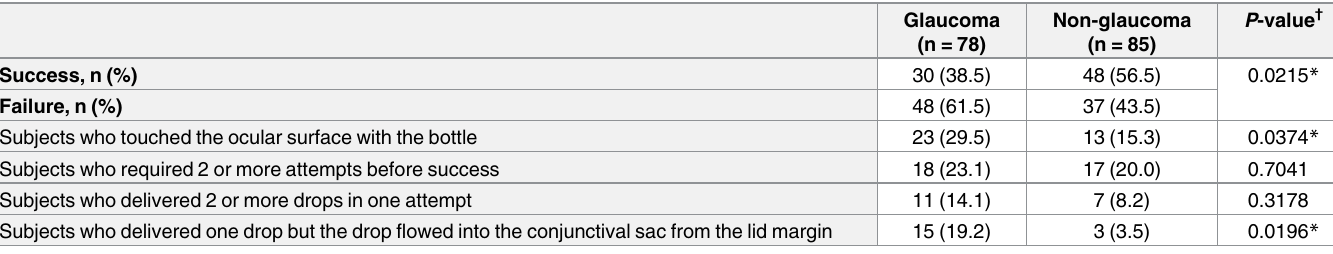
Table 2. Success and failure rates of eye drop instillation in two